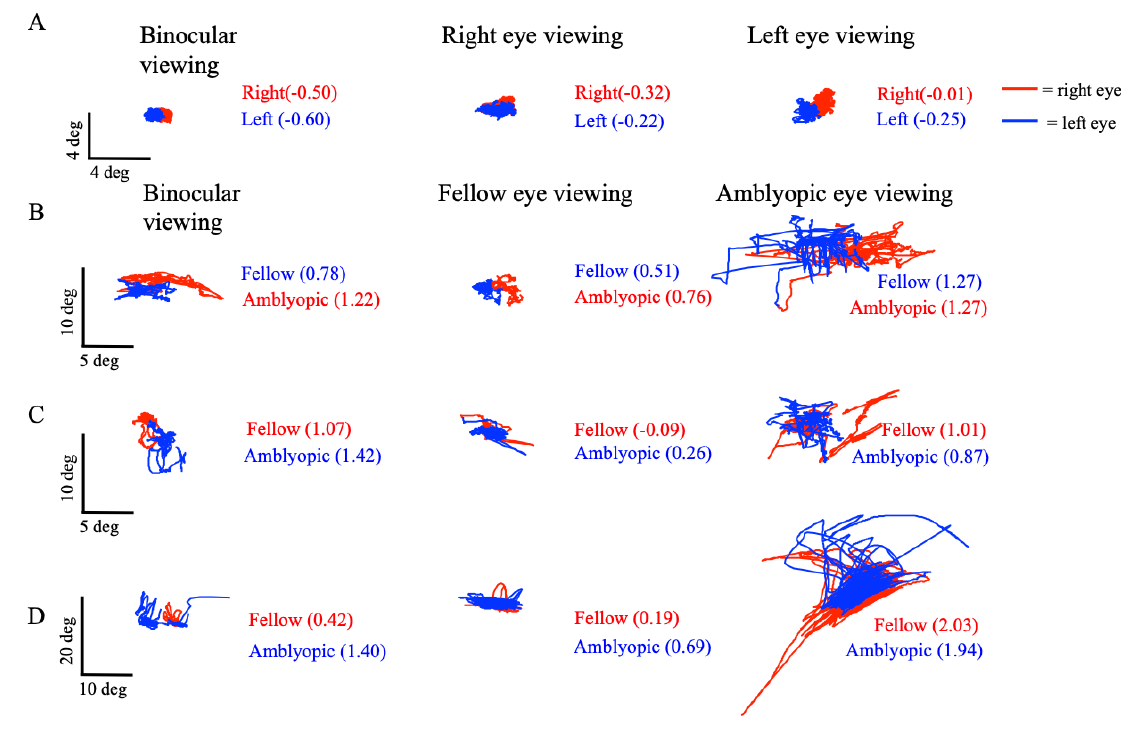
Fig. 2 : Representative horizontal and vertical eye position data in healthy controls (A) and subjects with amblyopia and no nystagmus (B), nystagmus but no FMN (C), and FMN (D) under fellow, amblyopic, and both eyes